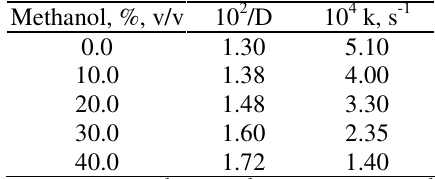
Table 2. Effect of Variations of ionic strength on the reaction